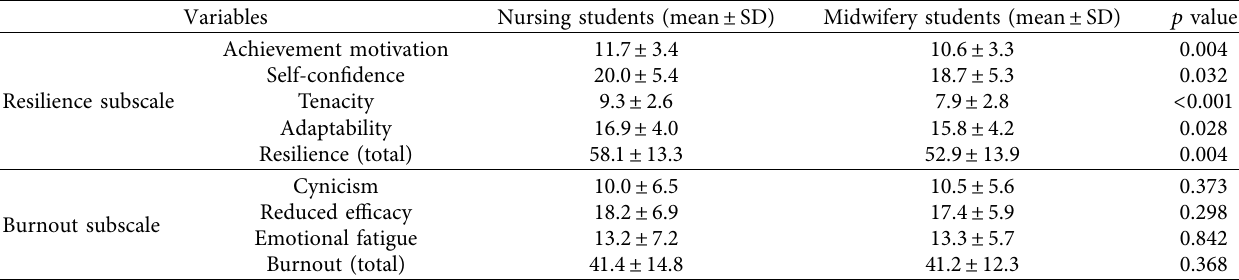
Table 2: Comparison of resilience and academic burnout in nursing and midwifery students.